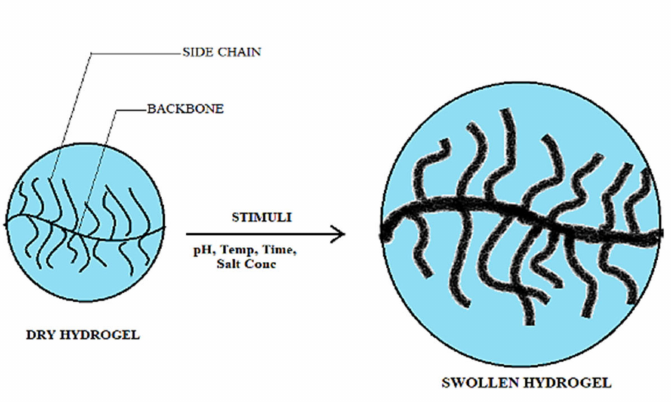
Figure 5. Swelling-deswelling of hydrogels with respect to stimuli pH, temperature, contact time, salt concentration.